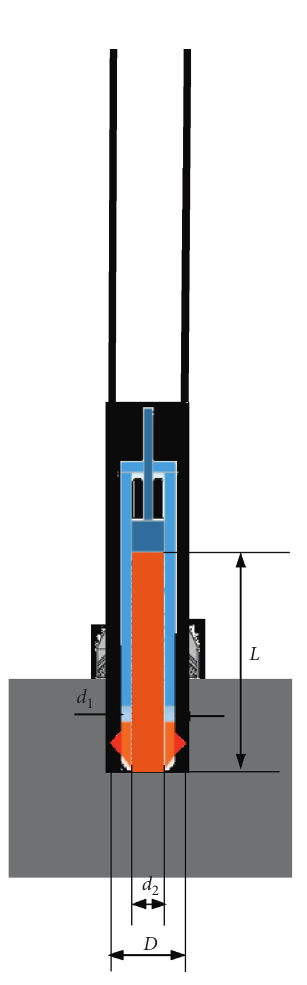
Figure 3: Structural parameters of coring system. Table 2: Structural parameters and optimization objectives of traditional